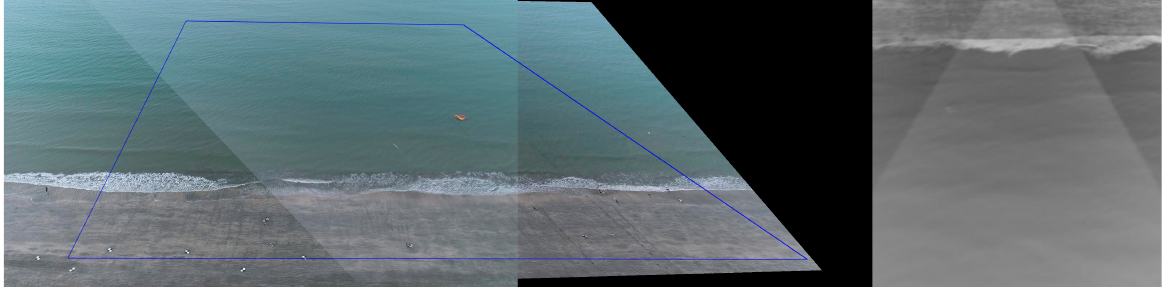
Figure 17. The range of ROI (200 m × 200 m) and its orthoimage.